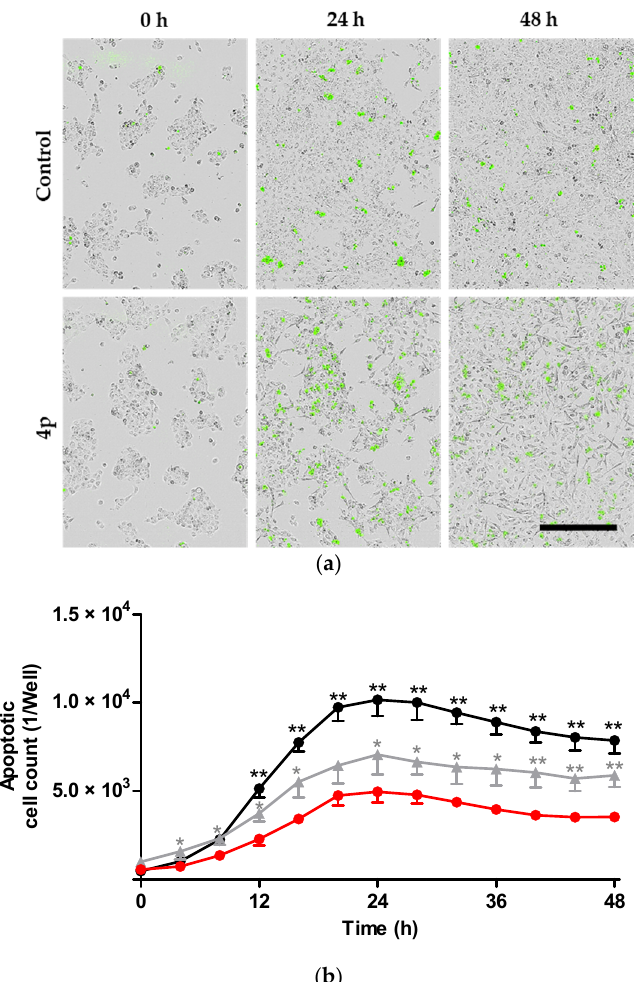
Figure 4. Induction of apoptosis by 4p in cultured A431 cells. ( a ) Representative phase contrast images of A431 cells cultured in a 96-well plate and treated with 20 µM of 4p or vehicle (1% DMSO control). All wells received IncuCyte ® caspase-3/7 green dye at a final concentration of 5 µM simultaneously. Images were taken at three different time points: directly after treatment (0 h), at 24 h, and 48 h following treatment. Green dots in the images represent apoptotic cells. Scale bar (400 µm) for all images is shown in black. ( b ) Monitoring of apoptotic events in cells treated with either 1 µM (gray) or 20 µM (black) of 4p , compared to control (red) over a period of 48 h. Data represent mean ± SD from an experiment with three replicates. * p < 0.05, ** p < 0.01.